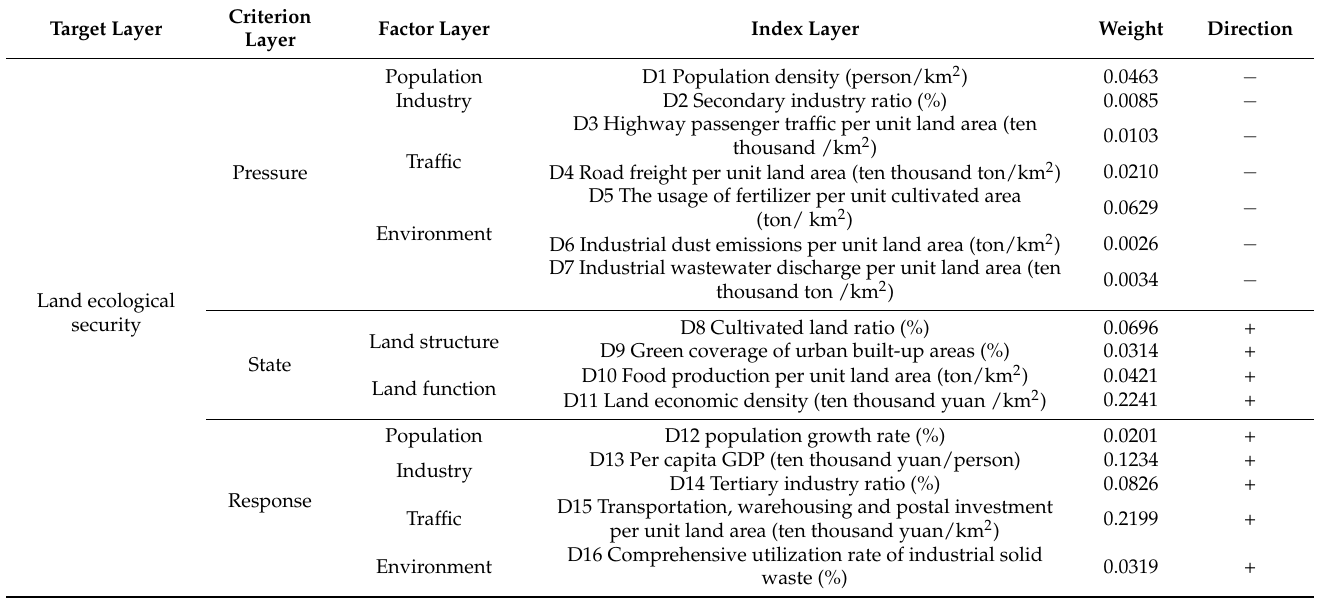
Table 1. LES evaluation index system for the BTH